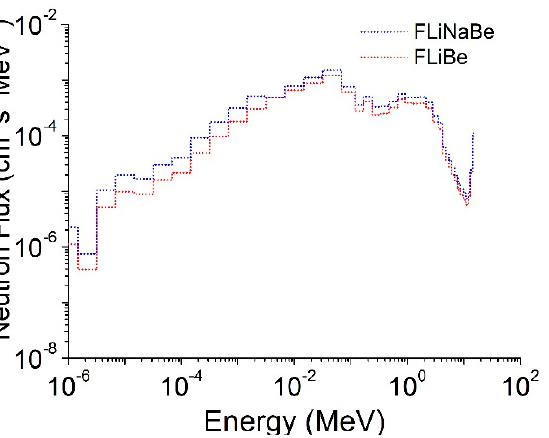
Figure 7. Comparison of the neutron energy spectrum with FLiBe and with FLiNaBe.